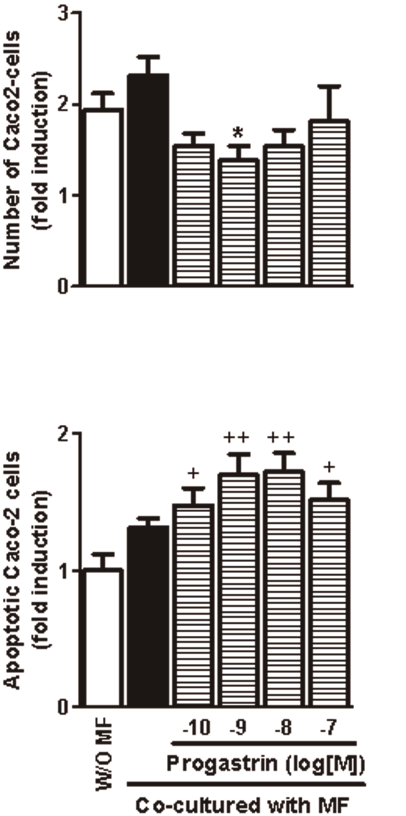
Figure 6. Influence of progastrin-treated macrophages on colorectal cancer cells. The effects of human monocyte-derived macrophages obtained in the presence or absence of progastrin on the number (A) and the rate of apoptosis (B) of Caco-2 cells were analyzed in a co-culture system (24 h, n=4). Bars represent mean 6 SEM. *P , 0.05 vs corresponding value in vehicle-treated macrophages, + P , 0.05 and ++ P , 0.01 vs cells incubated with an empty insert (w/o MF).